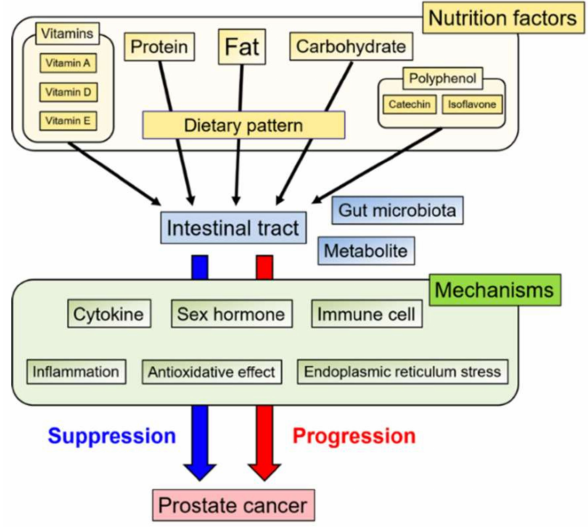
Figure 1. Schema of various nutrition factors and mechanisms involved in the progression or suppression of prostate cancer via the intestinal